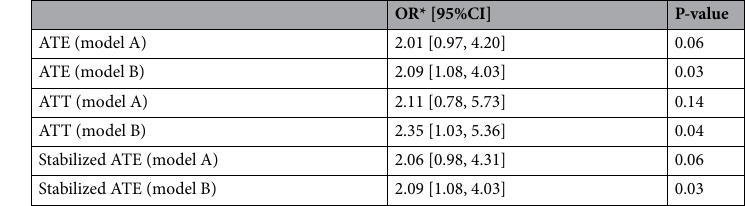
Table 5. The achievement ratio for BP control after SGLT2i treatment compare to GLP1Ra treatment by the analysis of the generalized linear model. The truncation on 99 percentiles is utilized in model A, and the trimming by 0.05 ≦ PS ≦ 0.95 is utilized in model B. a Odds ratio for SGLT2i treatment compared to GLP1Ra